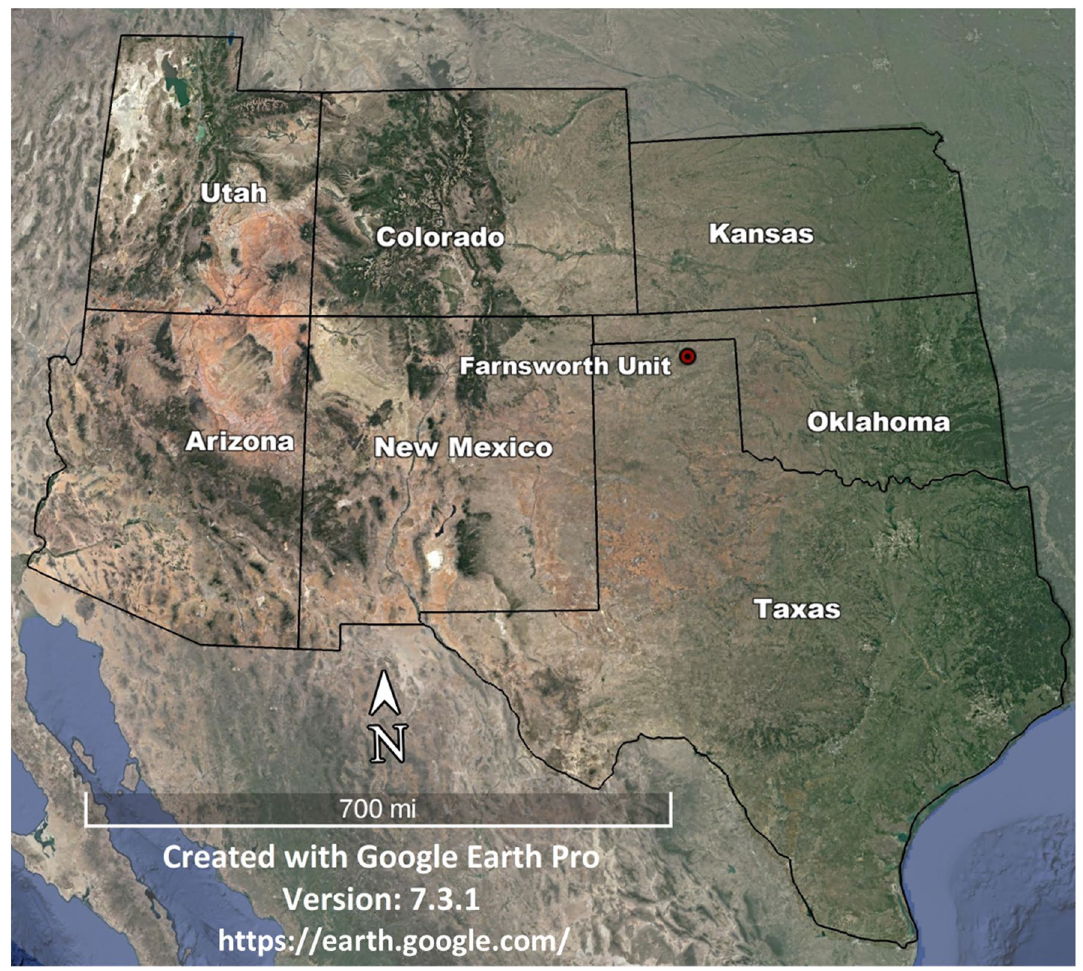
Figure 1. Location of FWU indicated by the red circle 33